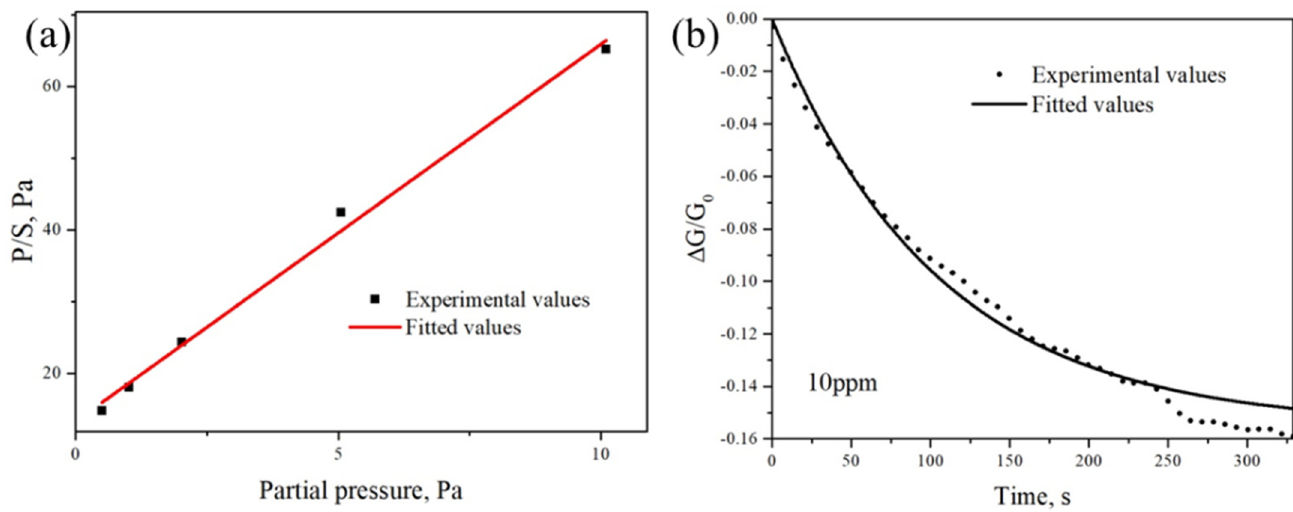
Figure 3. ( a ) P/S as a function of partial pressure P of NH 3 . The red line is the fitted linear curve. ( b ) FG sensor response to NH 3 at ambient pressure. The dashed line shows the best fitted curve.